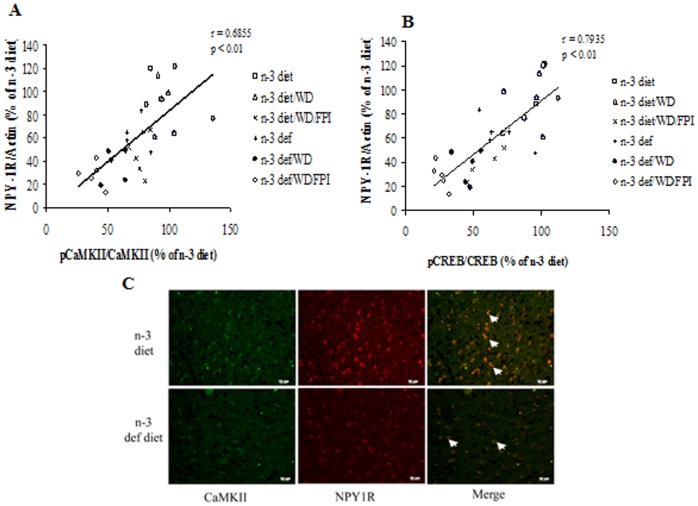
Association between molecules related with synaptic plasticity and anxiety-like behavior.Correlation analysis revealed a positive correlation between phosphorylated CaMKII and level of NPY1R (A) and phosphorylated CREB and level of NPY1R (B). (C) Immunoflouroscent staining for CaMKII and NPY1R proteins in coronal sections of frontal cortex region from omega-3 (n-3 diet) and omega-3 deficient (n-3 def) diet animals. Positive staining (green for CaMKII, red for NPY1R and yellow for co-stained cells, scale bar: 20 µm).